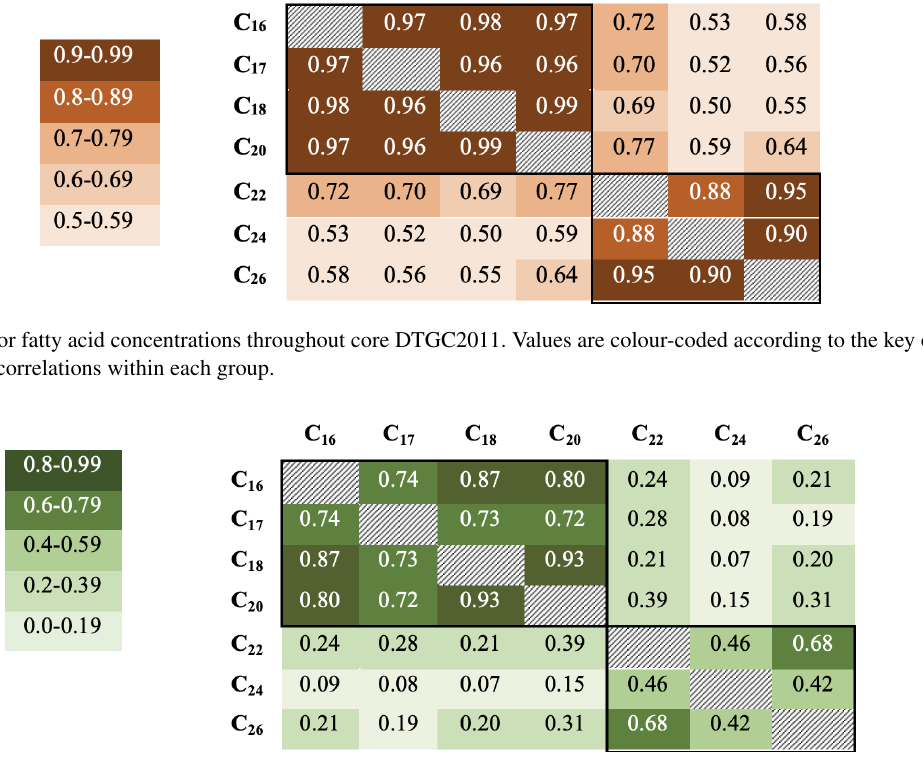
Figure 4. R 2 values for fatty acid concentrations in core DTGC2011 below 25cm only. Values are colour-coded according to the key on the left. The black border denotes correlations within each